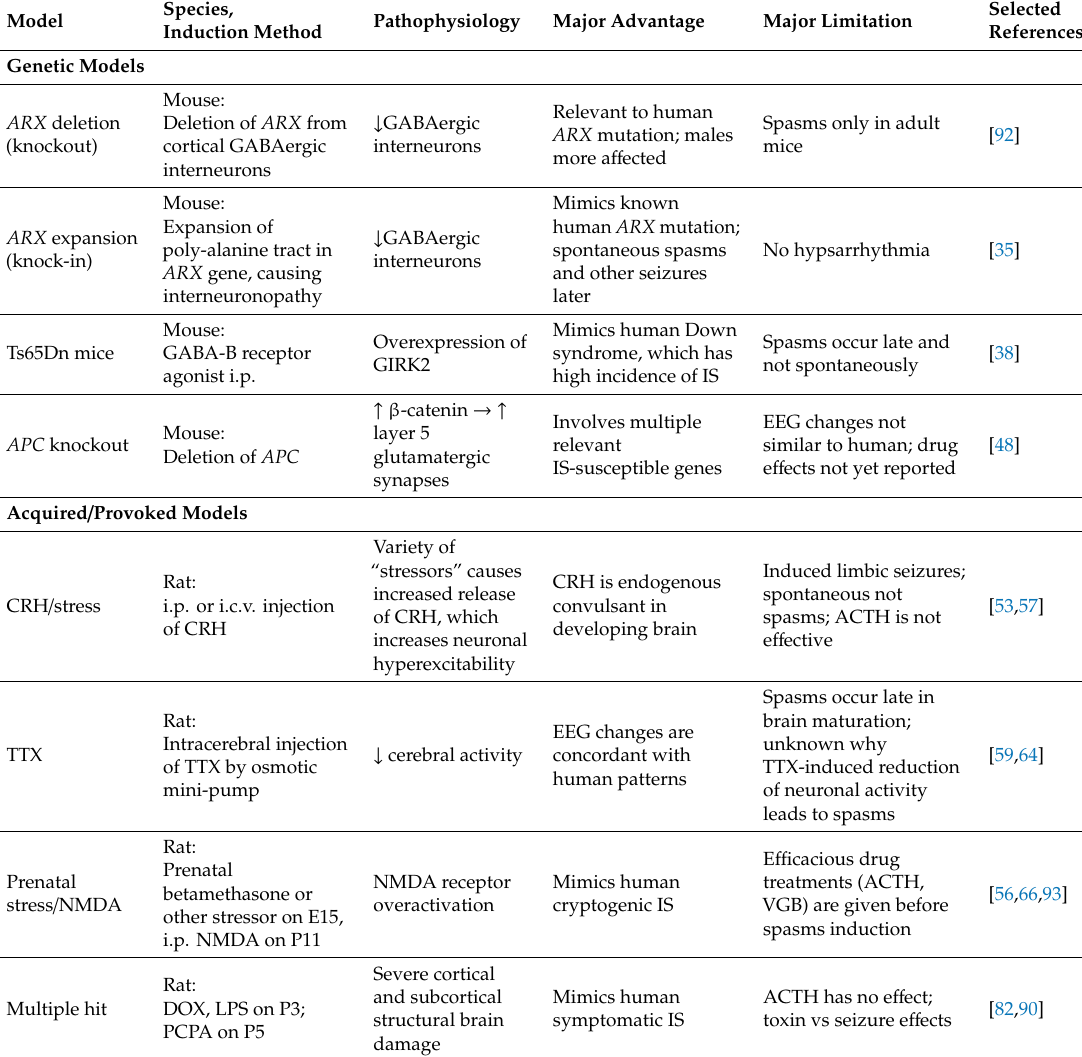
Table 2. Summary of Selected Currently Described Pre-clinical Models of Infantile